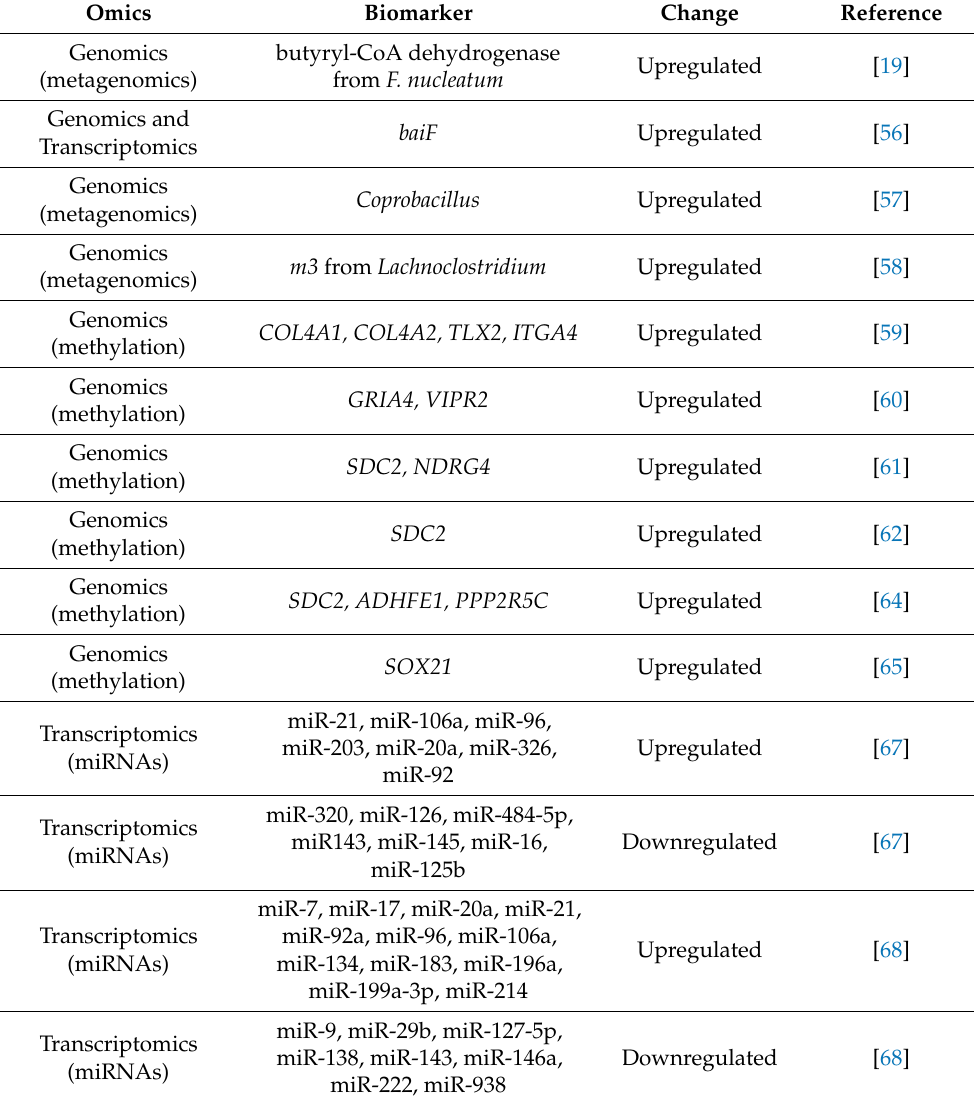
Table 3. Main biomarkers found in stool samples of CRC patients with different omics technologies.